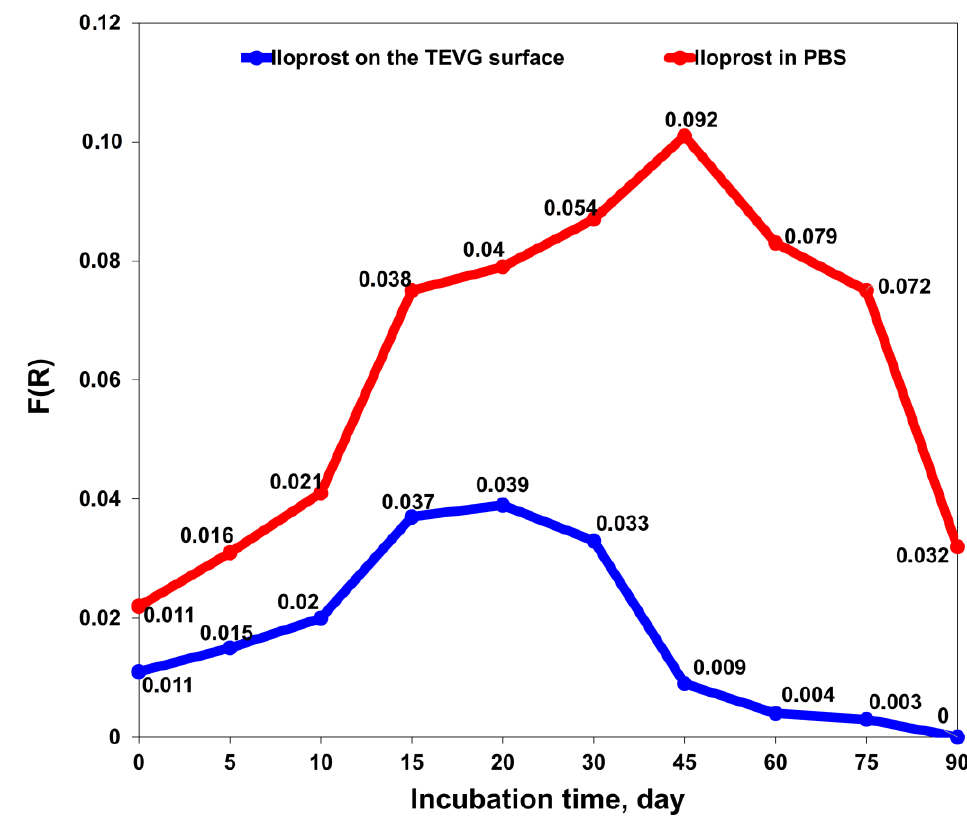
Figure 3. Release kinetics of iloprost from PCL Ilo/CAD TEVGs over 90 days measured by Fourier- transform infrared spectroscopy. The graph represents iloprost content on the TEVG luminal surface (blue line and dots) and in phosphate-buffered saline (red line and dots) at ascending time points of incubation (1, 5, 10, 15, 20, 30, 45, 60, 75 and 90